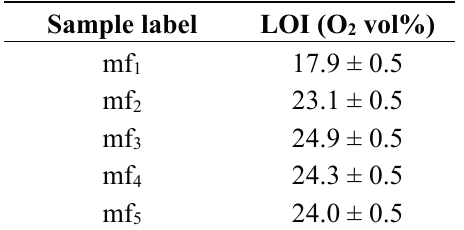
Table 5. LOI performances of nonwoven